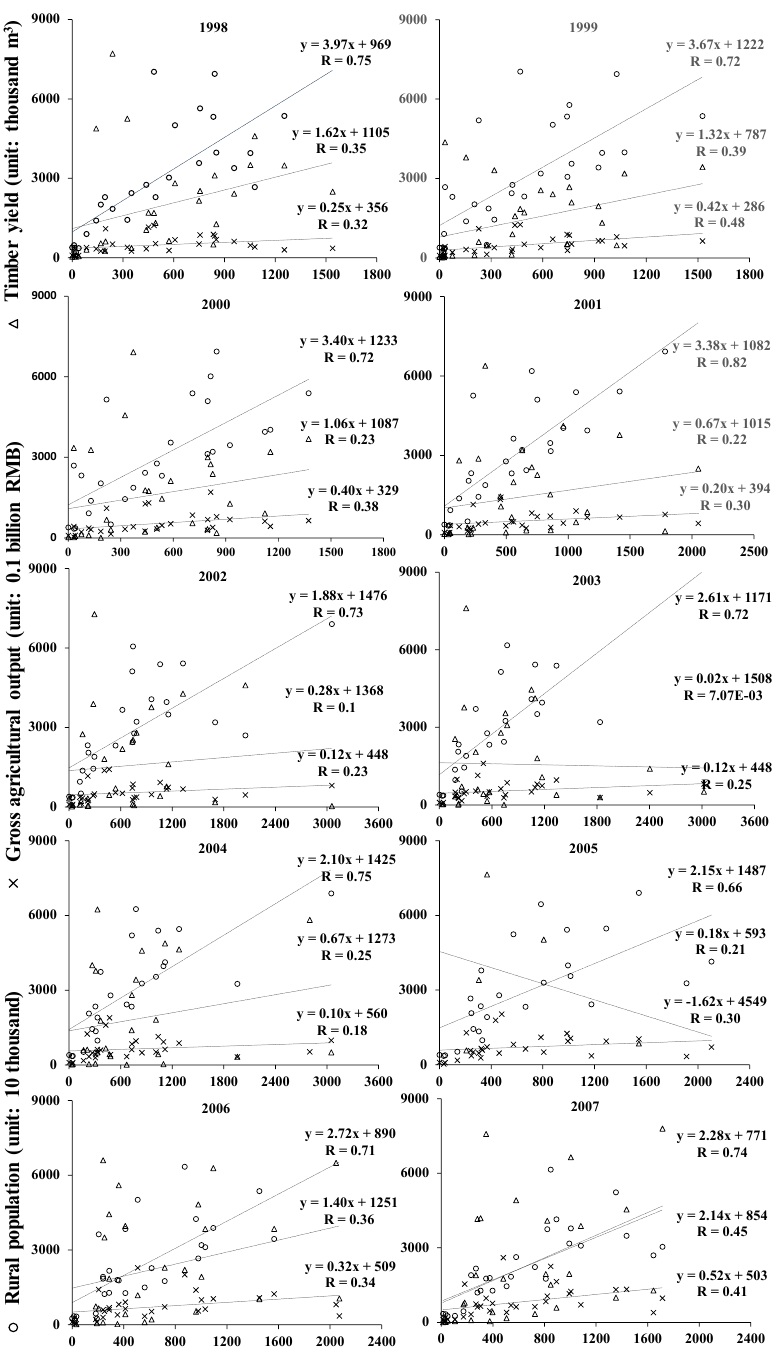
Figure 1. Regression analysis between firewood consumption at province resolution and (1) rural population, (2) gross agricultural output, and (3) timber yield denoted by circles, crosses, and triangles, respectively. Regression equations for each figure are provided in the top, middle, and bottom